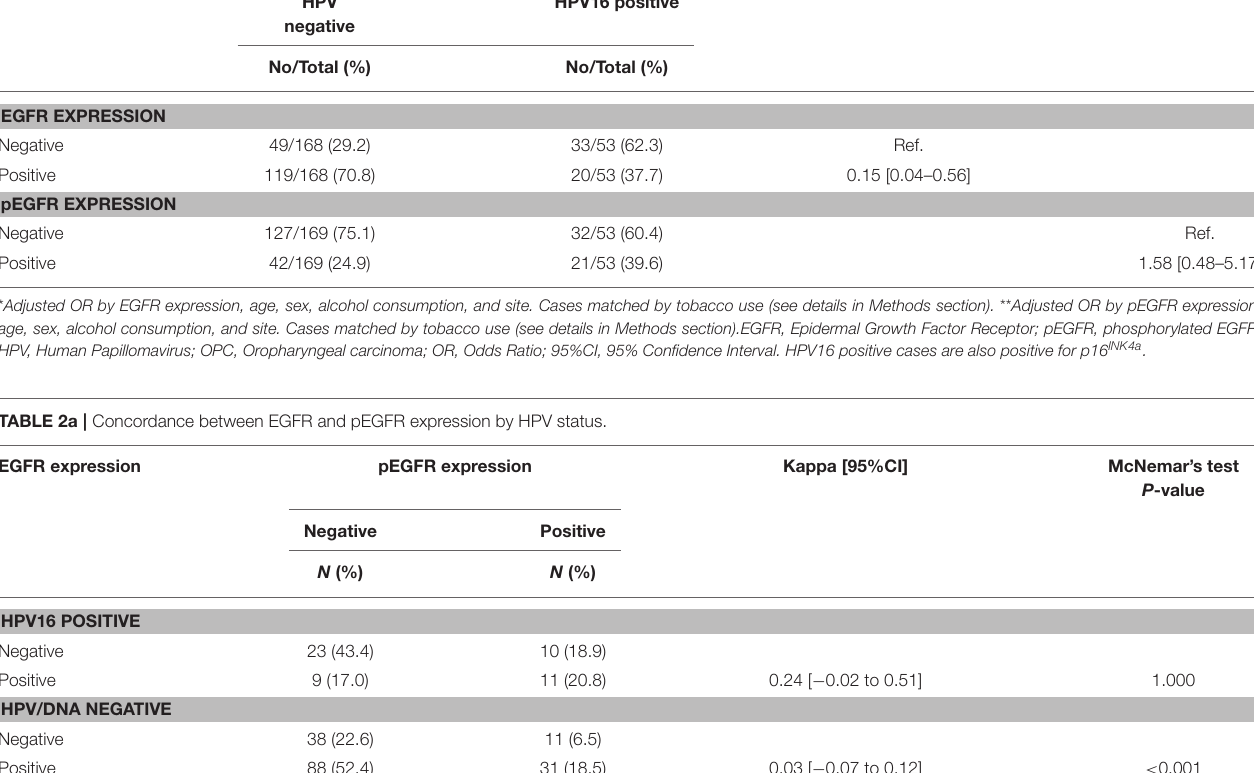
TABLE 1 | Association of differential EGFR and pEGFR levels between HPV16-positive OPCs and tobacco smoking-matched HPV-negative OPCs. Biomarker